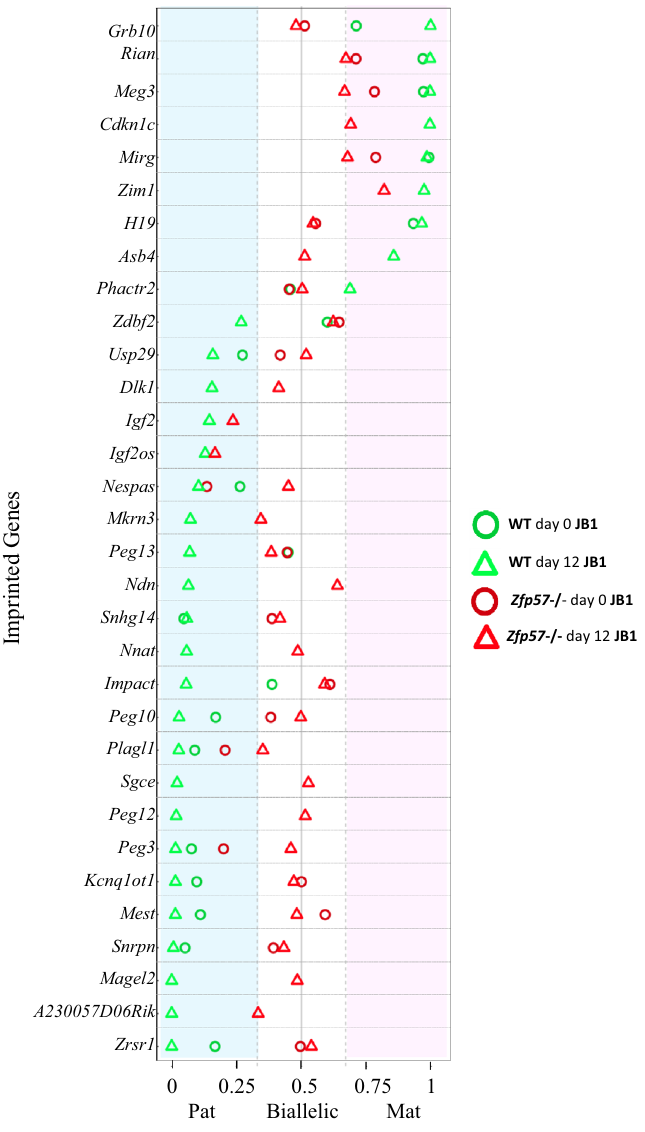
Figure 3. Allele-specific expression of imprinted genes in the wild-type and Zfp57 -/- day 0 and day 12-JB1 cells. Dot plot representing the allelic expression of imprinted genes in wild-type and Zfp57 -/- day 0- (green and red circles, respectively) and wild-type and Zfp57 -/- day 12- (green and red triangles, respectively) JB1 cells. The blue-shaded area corresponds to paternal (B6)-specific expression (allelic ratio interval: 0–0.33), the pink-shaded area corresponds to maternal (JF1)-specific expression (allelic ratio interval: 0.67–1), the white area corresponds to biallelically expressed genes (allelic ratio > 0.33 or < 0.67). The allelic ratio is the average of two biological duplicates (for details, see Supplementary Table 5). The data of wild-type and Zfp57 -/- ESCs are derived from a previous study 24